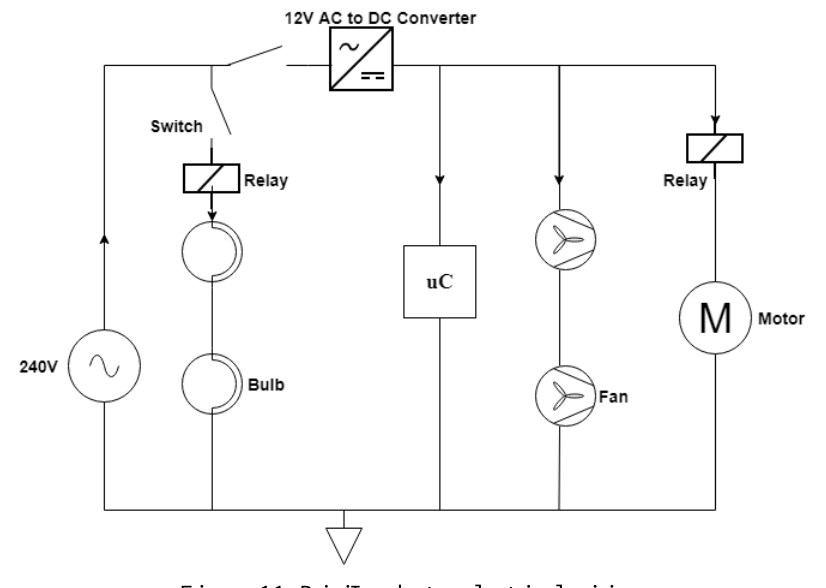
Figure 11. DigiIncubator electrical